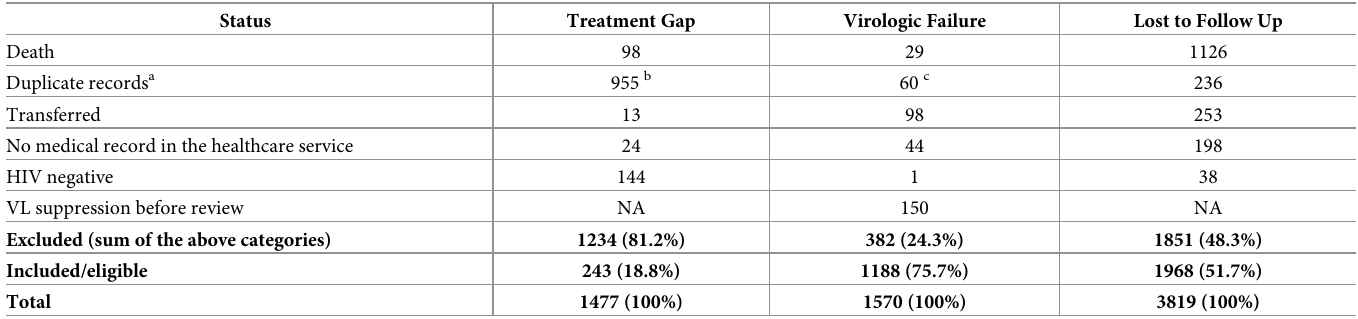
Table 2. Patients’ statuses in the SIMC report after analyses by the healthcare